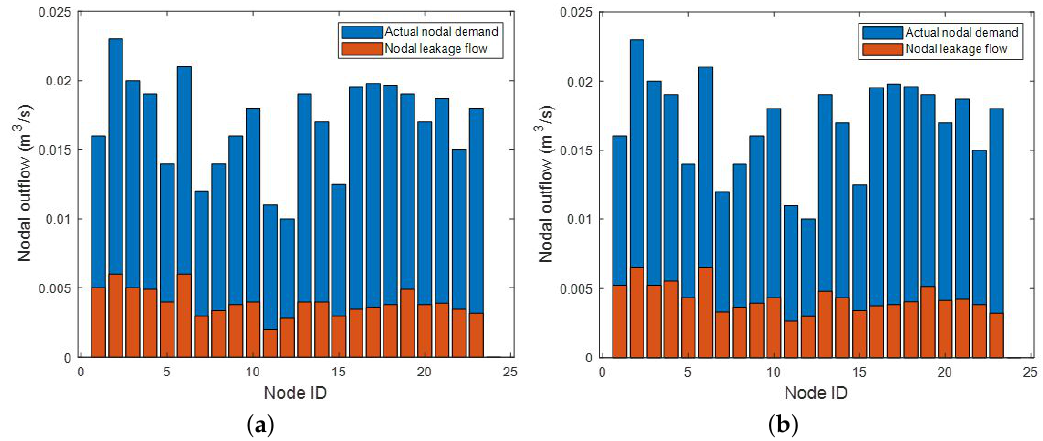
Figure 5. Nodal demand vs. the leakage outflow for each node for the case study network 2: ( a ) DDM analysis; ( b ) PDM analysis.